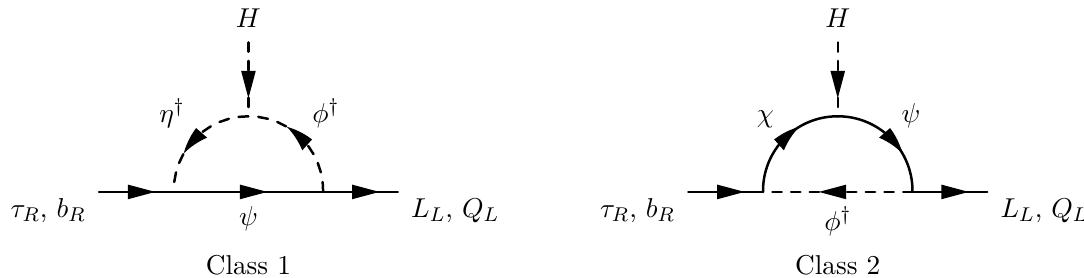
Figure 1. One-loop diagrams that generate effective τ -lepton and b -quark Yukawa couplings after integrating out the heavy, exotic